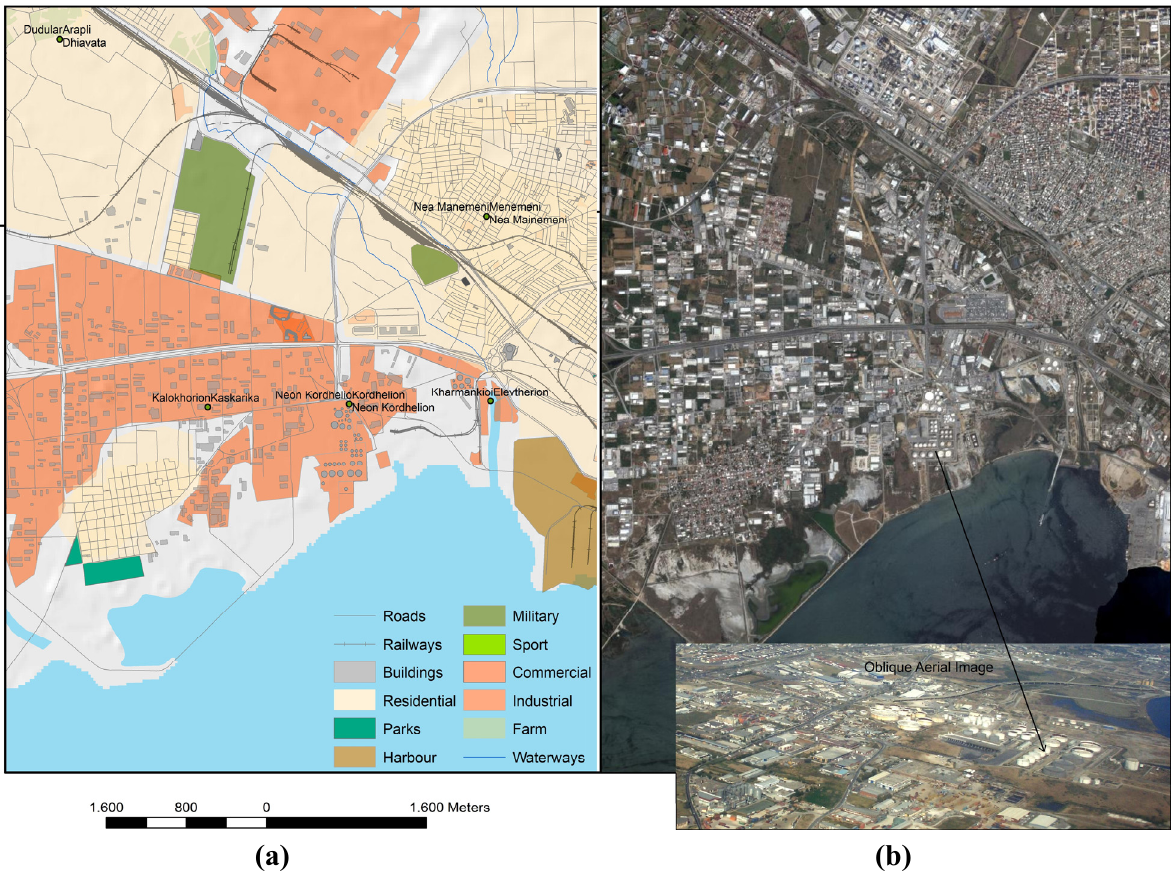
Figure 2. Land use classification based on ( a ) ArcGIS integrated OpenStreetMap-data